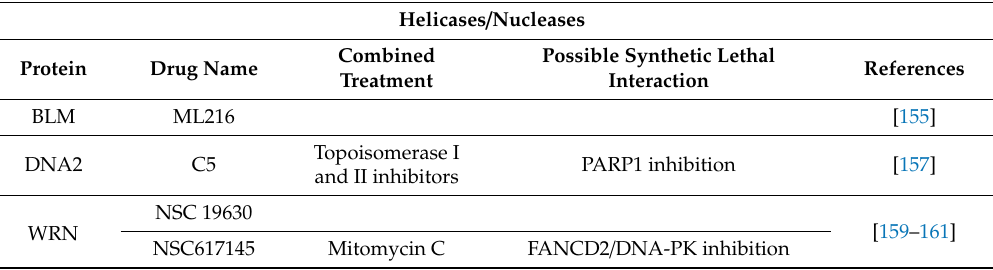
Table 4. Helicases and nucleases targeted in cancer therapy.